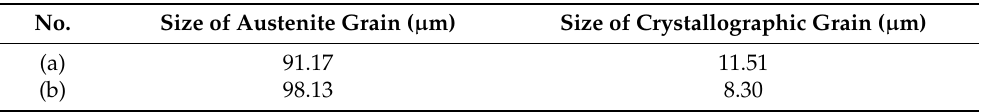
Figure 5. Optical micrographs of simulated CGHAZ with a heat input of 200 kJ/cm with ( a ) 0.073%, ( b ) 0.110% Nb. Table 5. Measured austensite grain size in simulated CGHAZ corresponding to samples shown in Figure 5.